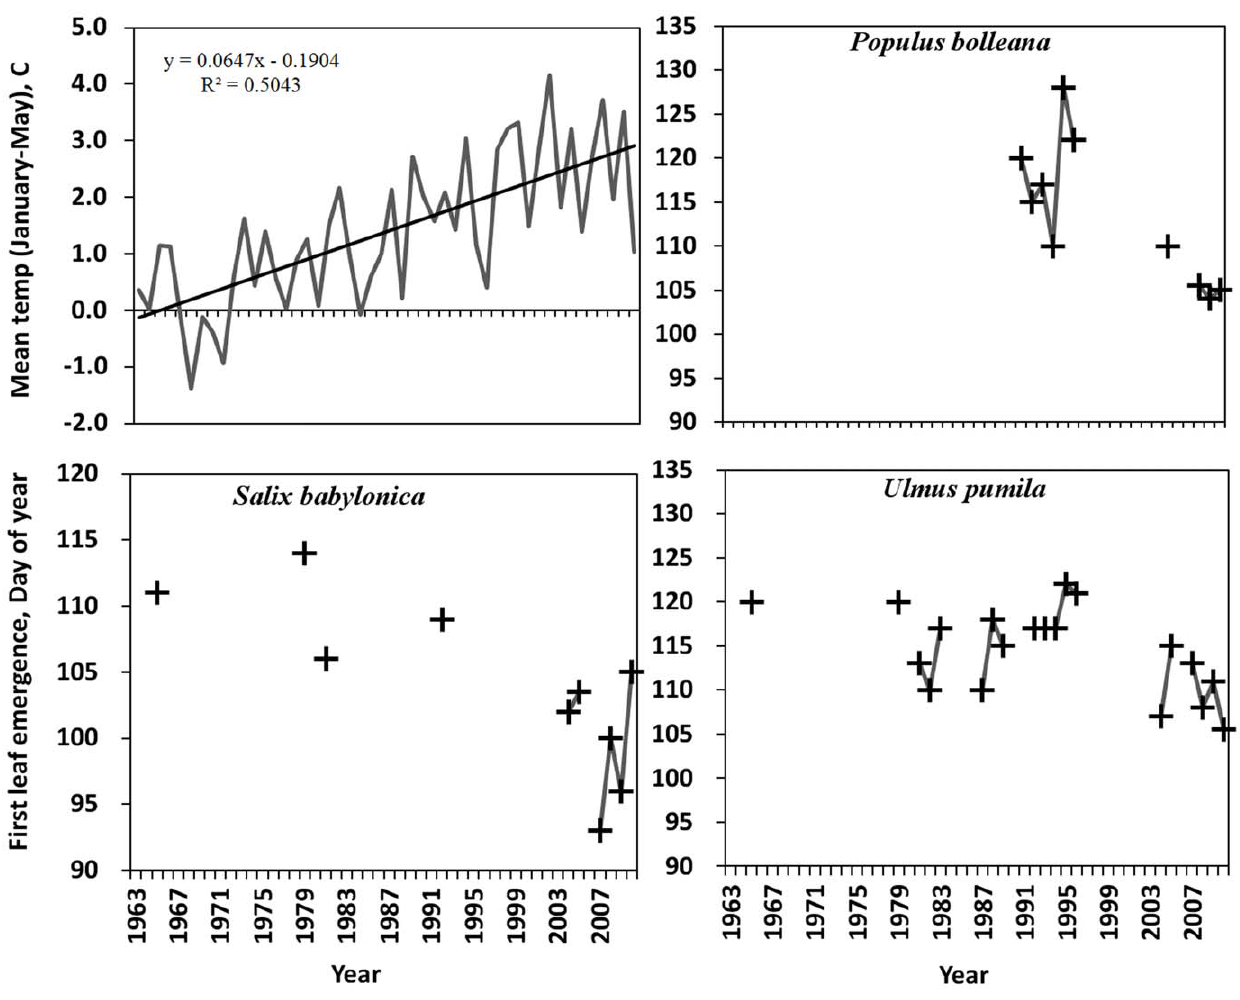
Figure 2. Historical changes in January–May mean air temperature (shown here with the fitted trend line) and timing of first leaf emergence for 3 tree species monitored in Hohhot arboretum during 1963–2010. Lines in phenology graphs connect contiguous data points and illustrate significant data gaps in the time-series.